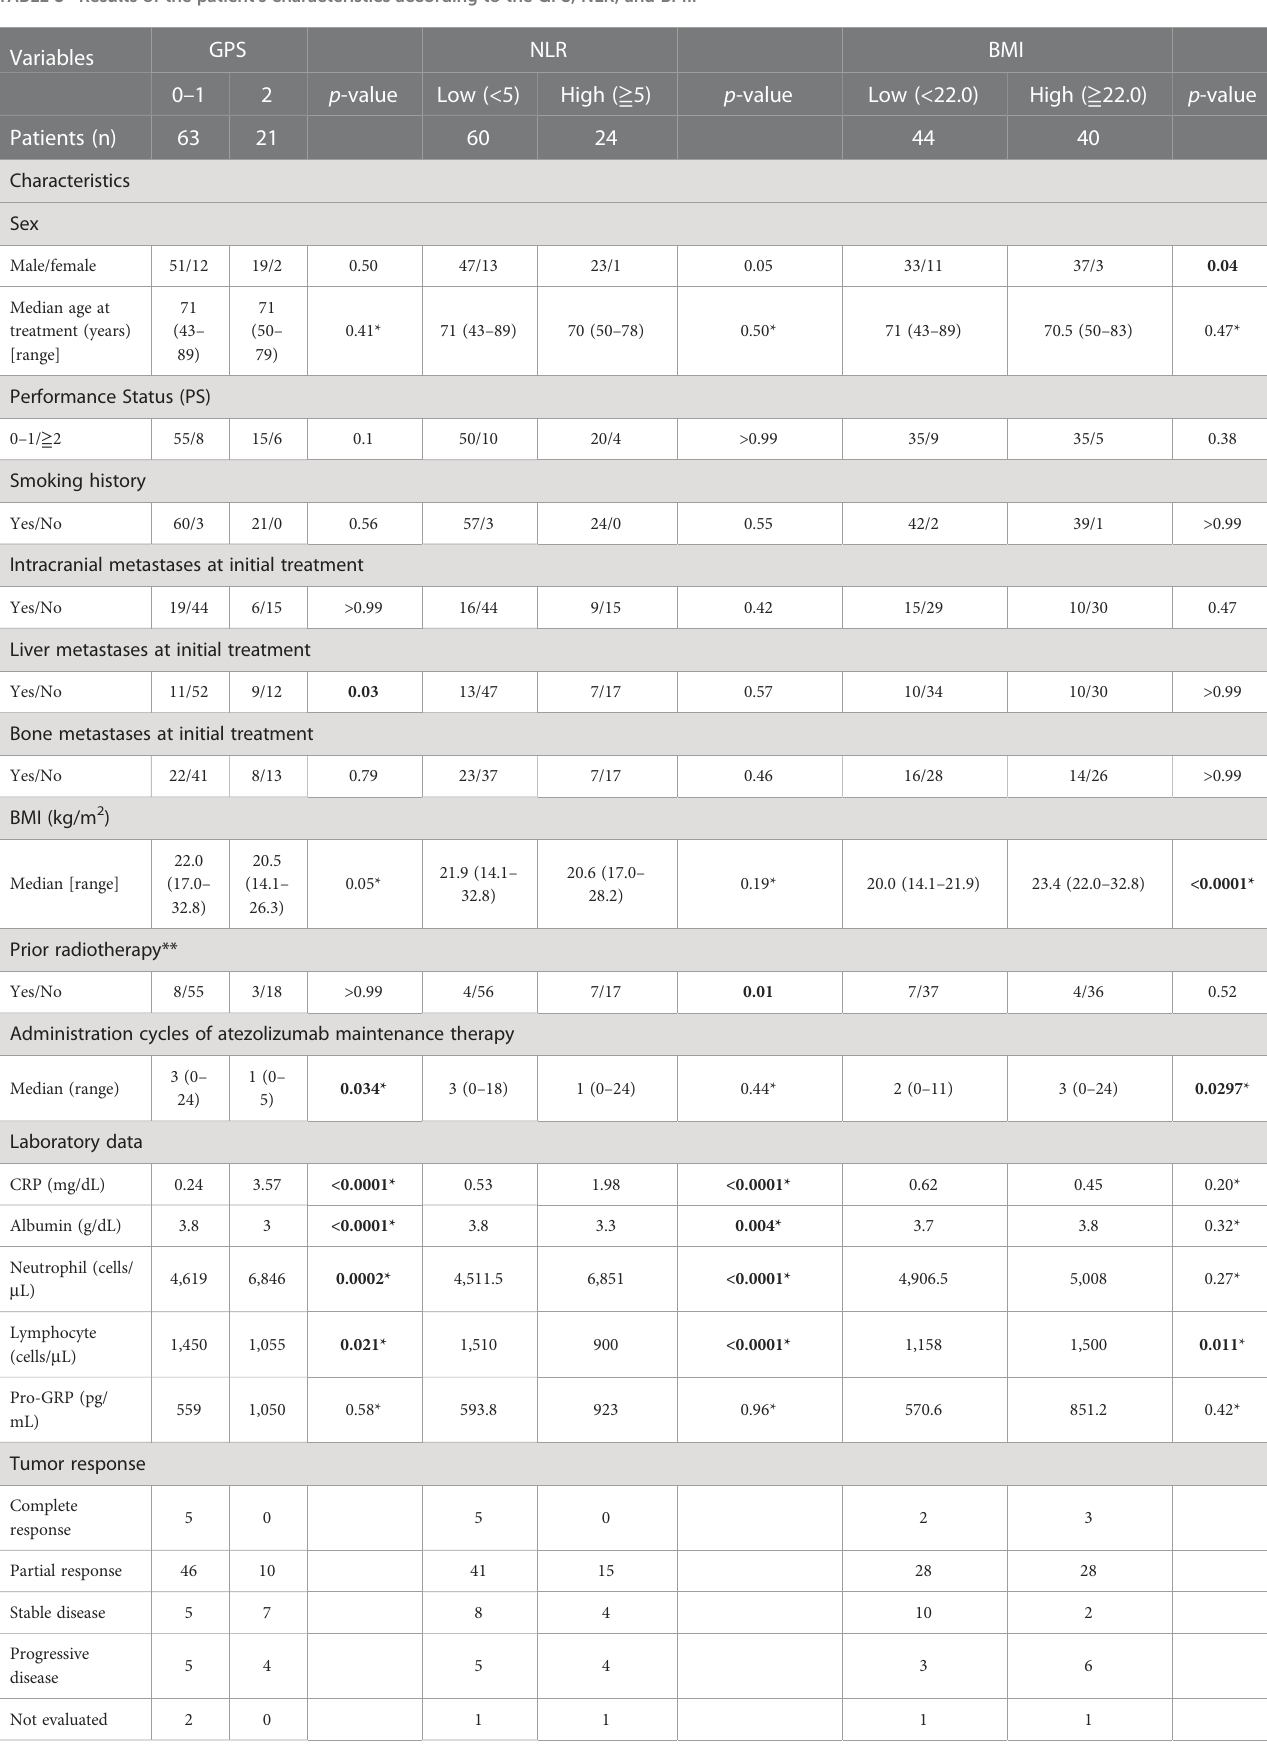
TABLE 3 Results of the patient ’ s characteristics according to the GPS, NLR, and